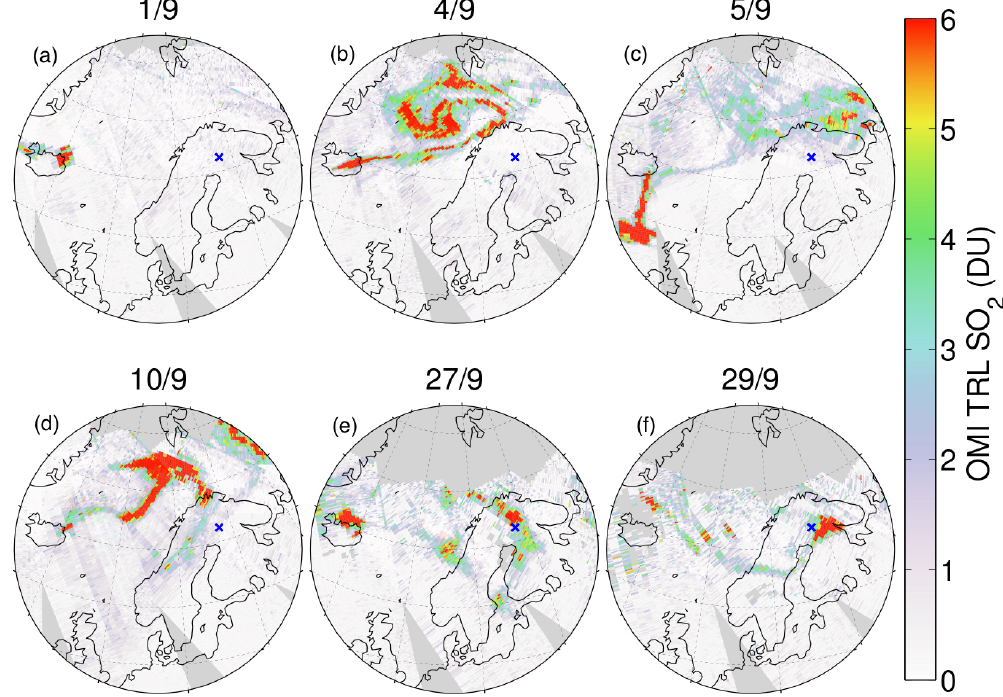
Figure 1. SO 2 total columns as seen from OMI SP TRL product during the Holuhraun fissure eruption for 6 days in September 2014. The dates (day/month) are indicated in the title of each panel. The blue crosses indicate the location of Sodankylä ground-based